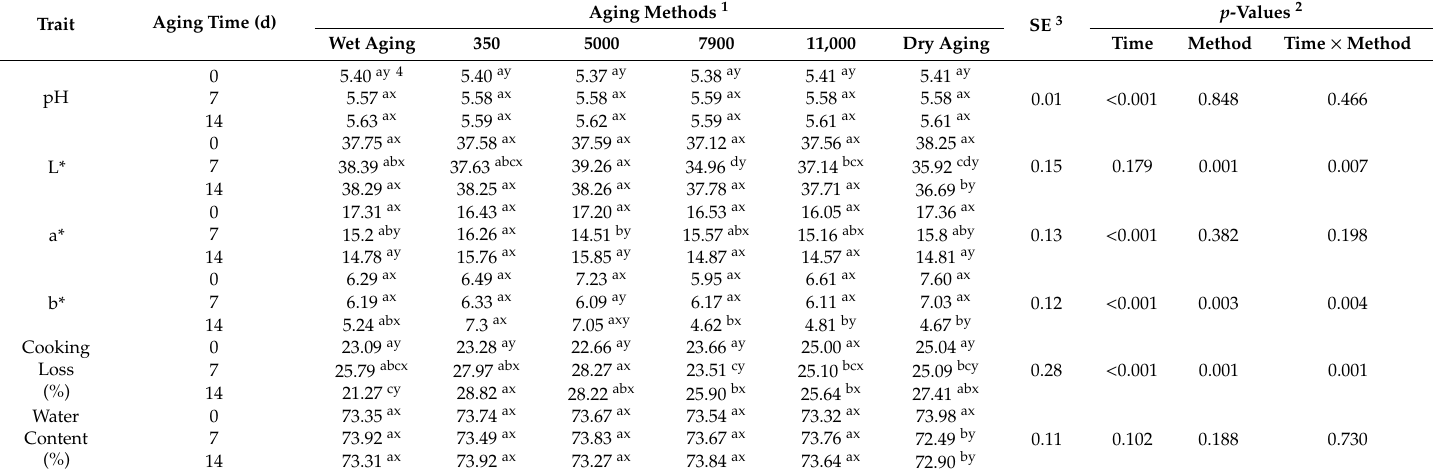
Table 2. E ff ects of di ff erent aging methods and aging time on the pH, L*, a*, b*, cooking loss, and water content of